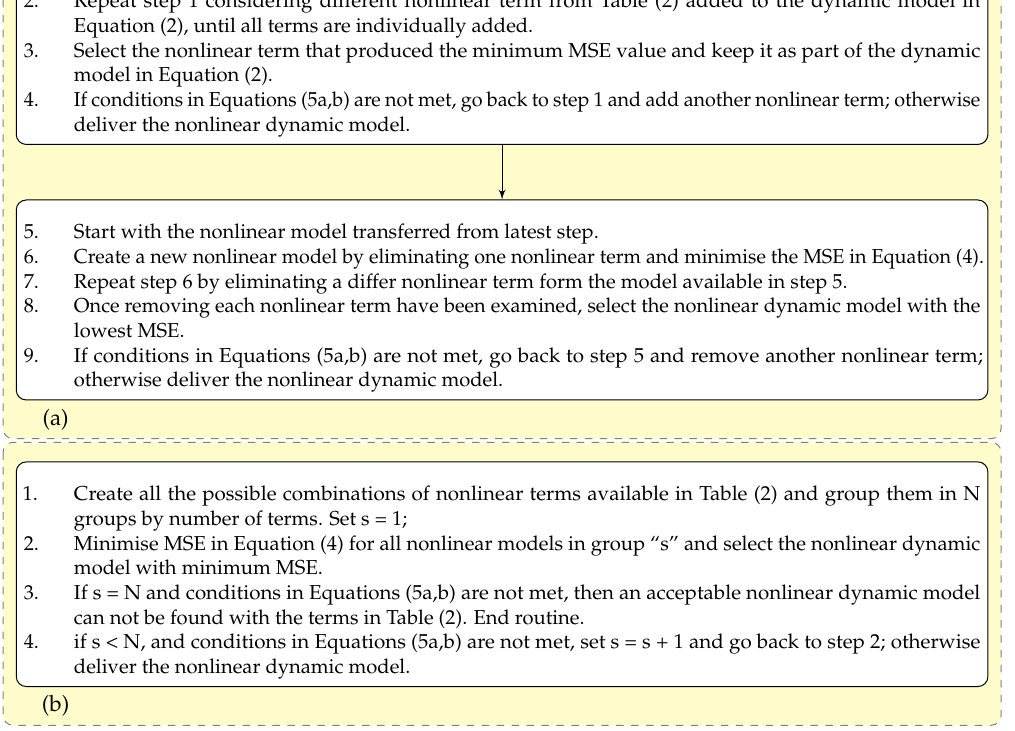
Figure 1. Nonlinear model selection algorithms ( a ) FB, ( b ) ES (adapted from